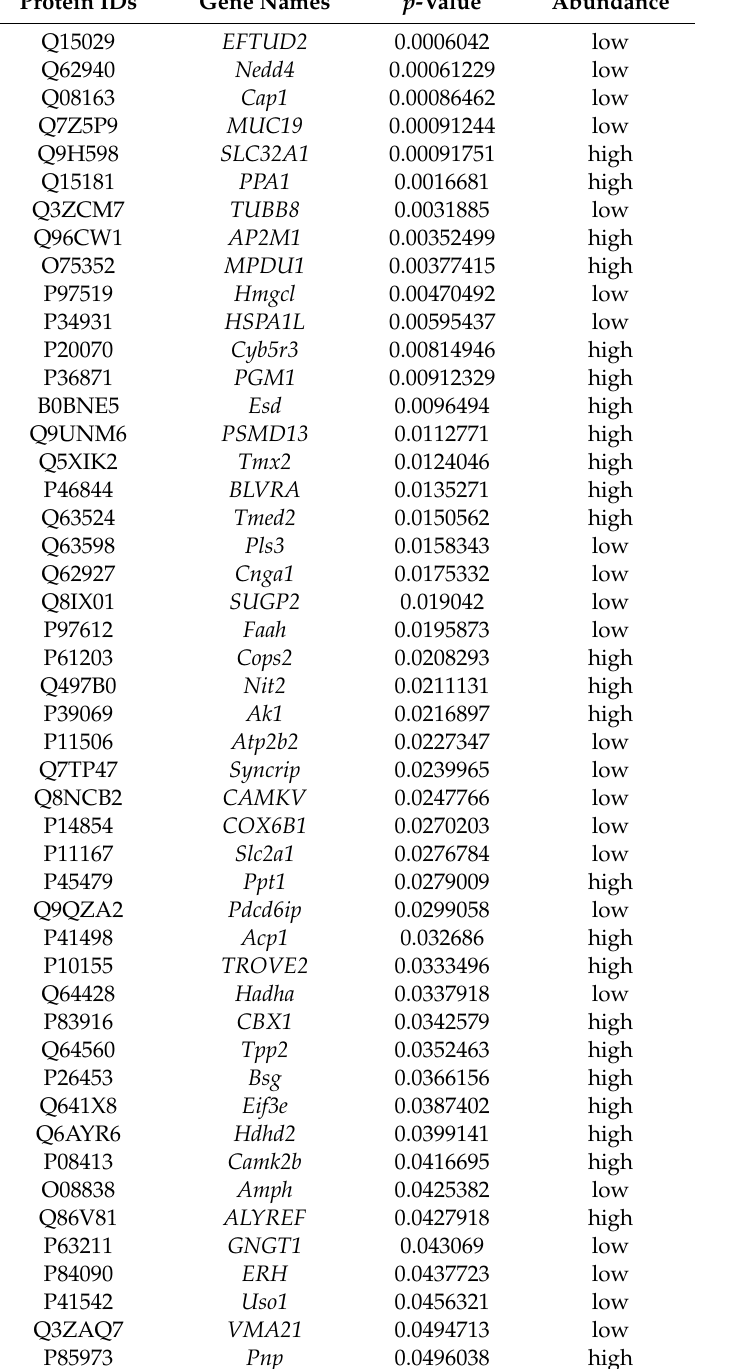
Table 1. List of the 48 significantly di ff erentially expressed retinal proteins identified in I / R